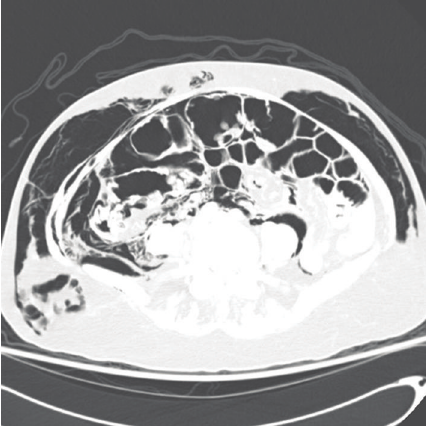
Figure 4: Transverse section of CT thorax showing subcutaneous emphysema, bilateral pneumothorax, and pneumomediastinum (arrow).